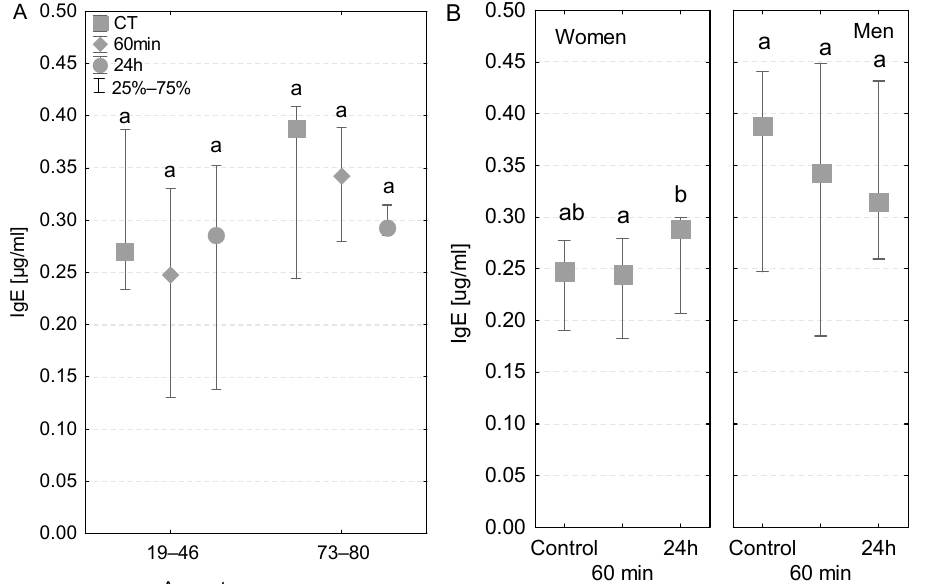
Figure 5. Serum IgE concentration (median ± quartile deviation; 25th and 75th percentiles). ( A ) Comparison based on the age of patients: 19–46 years and 73–80 years. ( B ) Comparison based on the sex of the patients. CT: measurement before the onset of CPB; 60 min: measurement at 60 min of the CPB onset; 24 h: measurement at 24 h after the onset of CPB. Values with different letters (a, b) indicate significant differences within the age or sex category (Friedman’s test or Mann–Whitney U test; p <